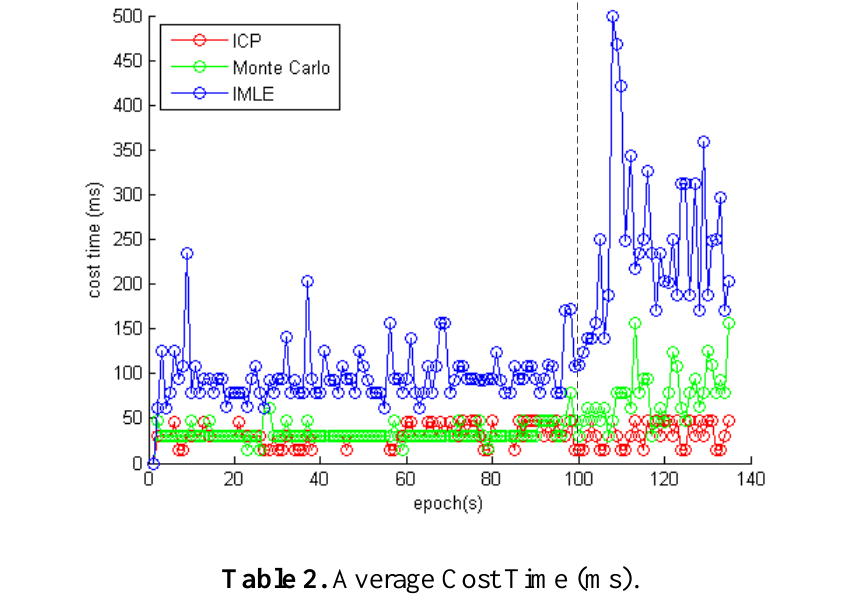
Figure 12. The time cost of each scan matching when using the different algorithms.